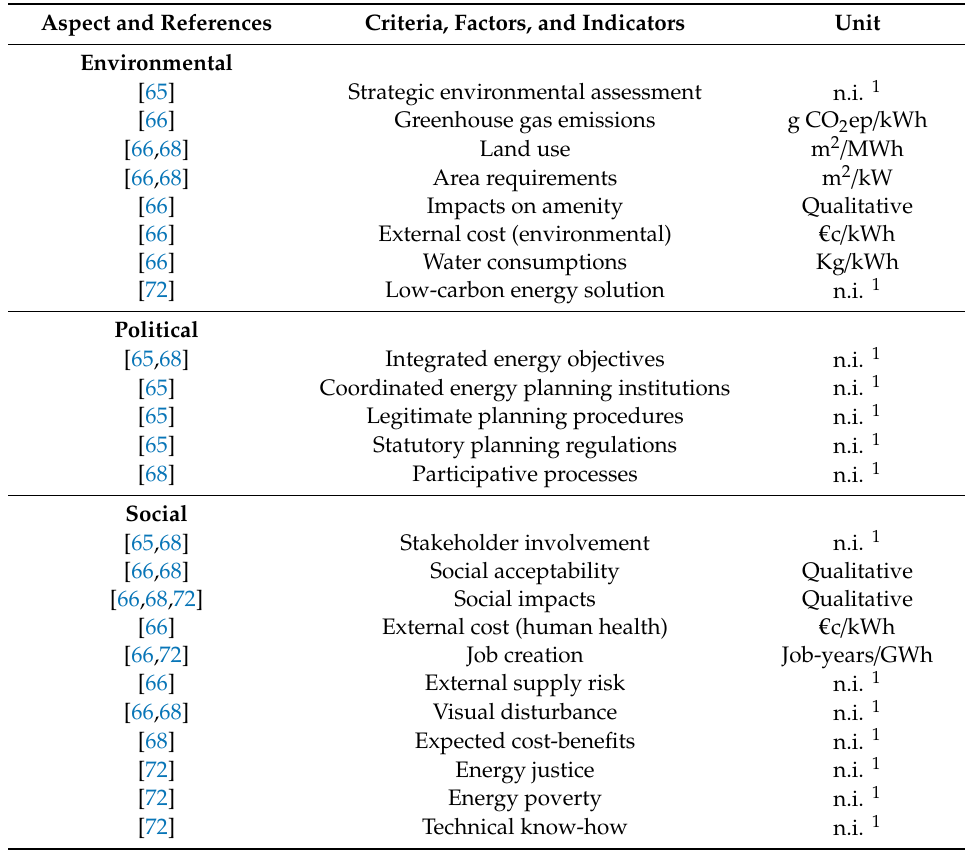
Table 2. Criteria, factors, and indicators associated with the main aspects beyond the techno-economic ones found in articles on the SEP